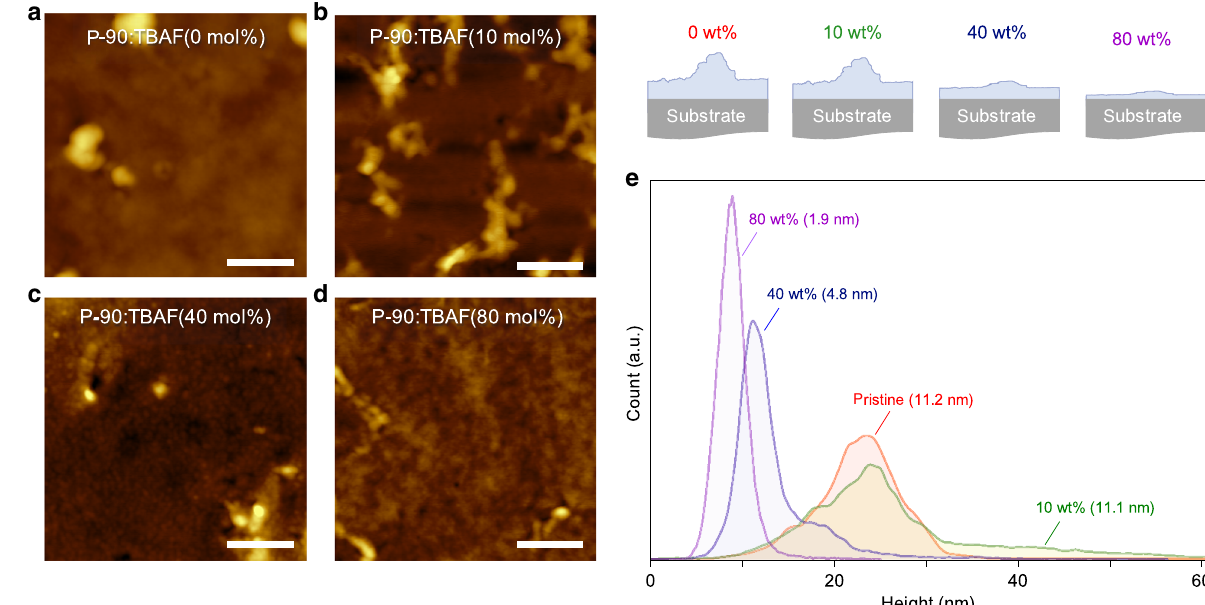
Fig. 4 The impact of molecular n-doping on morphology. Atomic force microscopy (AFM) images showing the topography of ( a ) P-90:TBAF(0 mol%), ( b ) P-90:TBAF(10 mol%), ( c ) P-90:TBAF(40 mol%) and ( d ) P-90:TBAF(80 mol%) thin- fi lms. Scale bars are 500 nm. e Surface height distribution histograms and surface roughness root mean square (RMS) values corresponding to the topography images in ( a – d ). All fi lms were deposited onto 580 × 580 µ m 2 Au electrodes and had been submerged in electrolyte prior to the